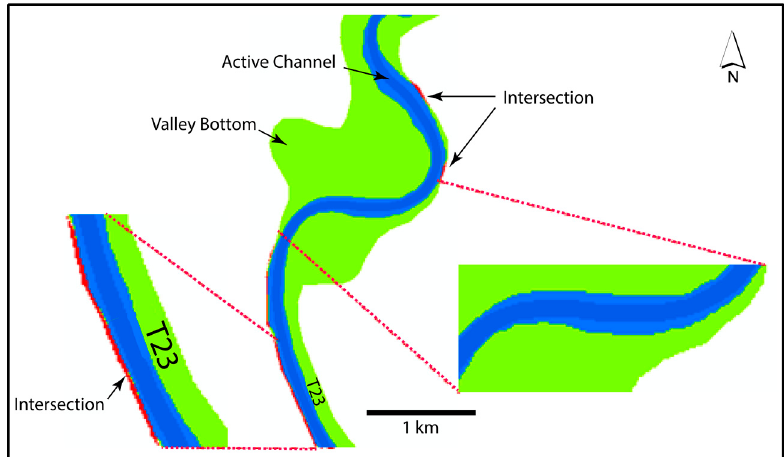
Figure 2. Confinement strongly depends on the segmentation (scale of analysis) adopted. Left: zoom of a segment fully confined (red lines at the border indicate contacts), at its specific scale; middle: a stretch of a river classified as partly confined at the given scale of analysis (the contacts between valley bottom (VB) margins and the active channel are marked with red, solid line); right: zoom of another segment fully unconfined, at its specific scale.